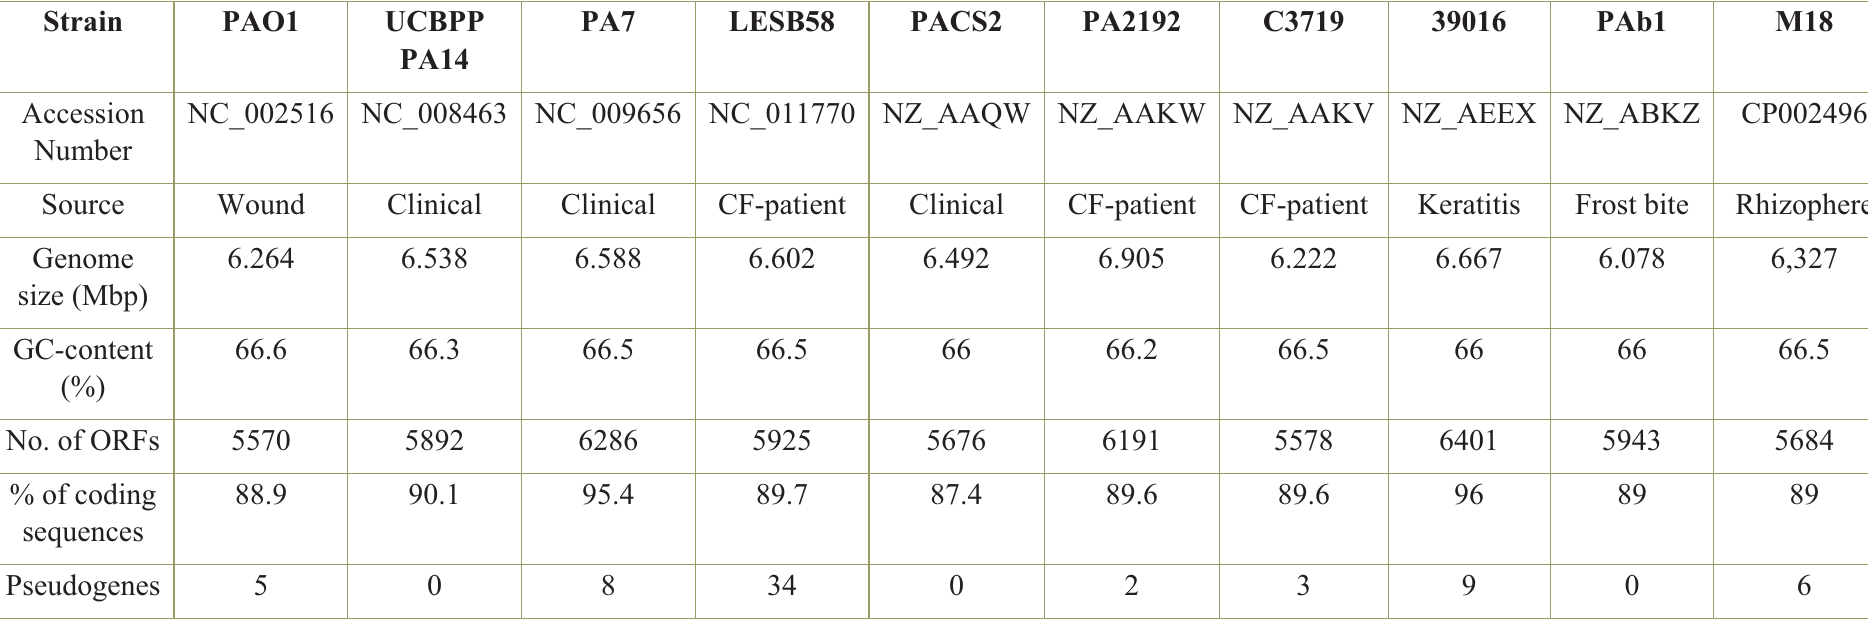
Table 2. Genomic features of sequenced P. aeruginosa strains adapted from KLOCKGETHER et al . [104] and completed using NCBI genome data